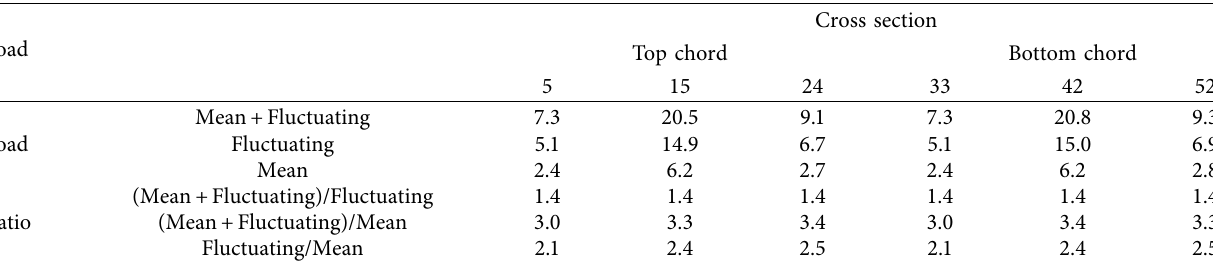
Figure 11: Structural displacement deformation diagram of plastic greenhouse at 27.9s when considering both the mean wind and the fluctuating wind. Table 1: Comparison of nodal displacement (unit: